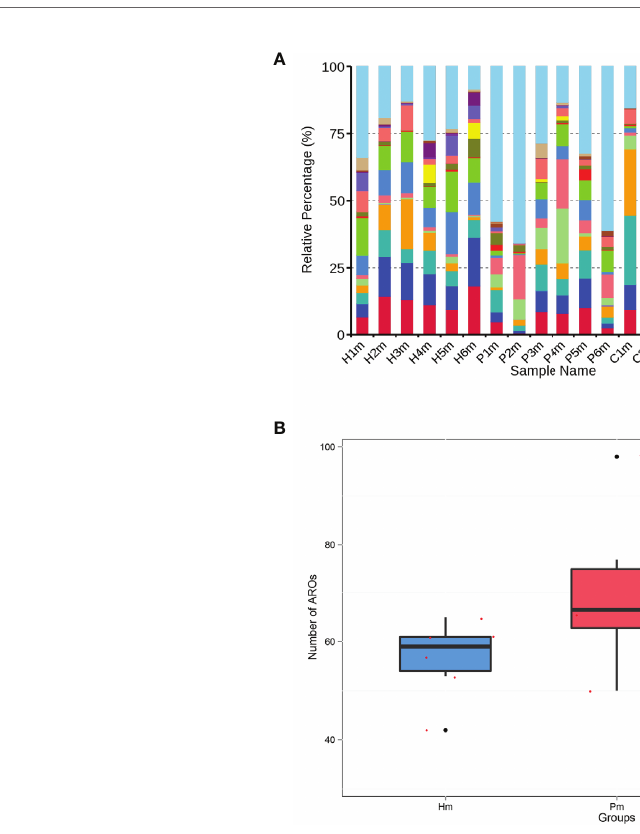
FIGURE 7 | Number of ARO genes and relative abundances of the top 20 ARO genes shared among the individuals in the Pm, Cm, and Hm groups. (A) Proportion of the top 20 ARO genes and other ARO genes. (B) Differences in the number of ARO genes among the Cm, Pm, and Hm groups. ARO, antibiotic resistance ontology; Hm, healthy individuals; Pm, patients with periodontitis alone; Cm, patients with Crohn ’ s disease and